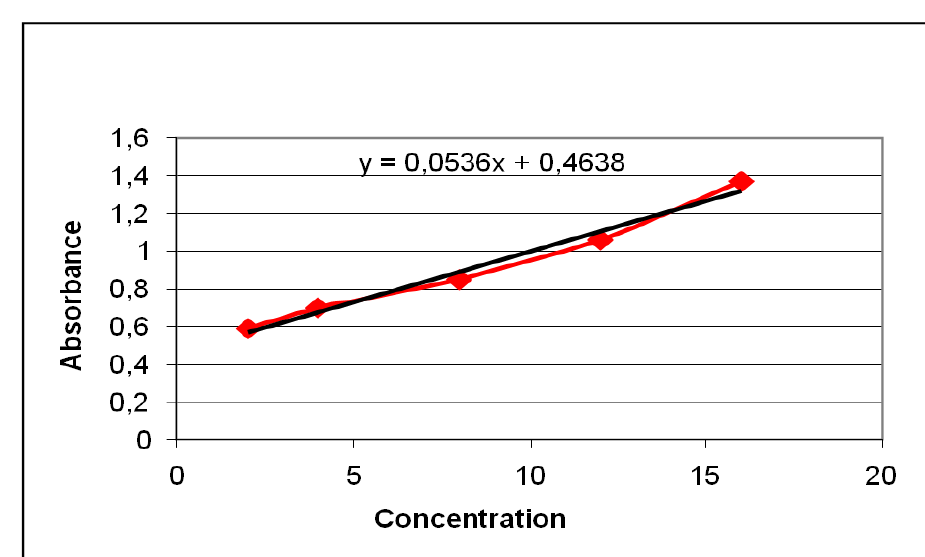
Fig. 1. The etalon curve obtained using the BSA standard solution